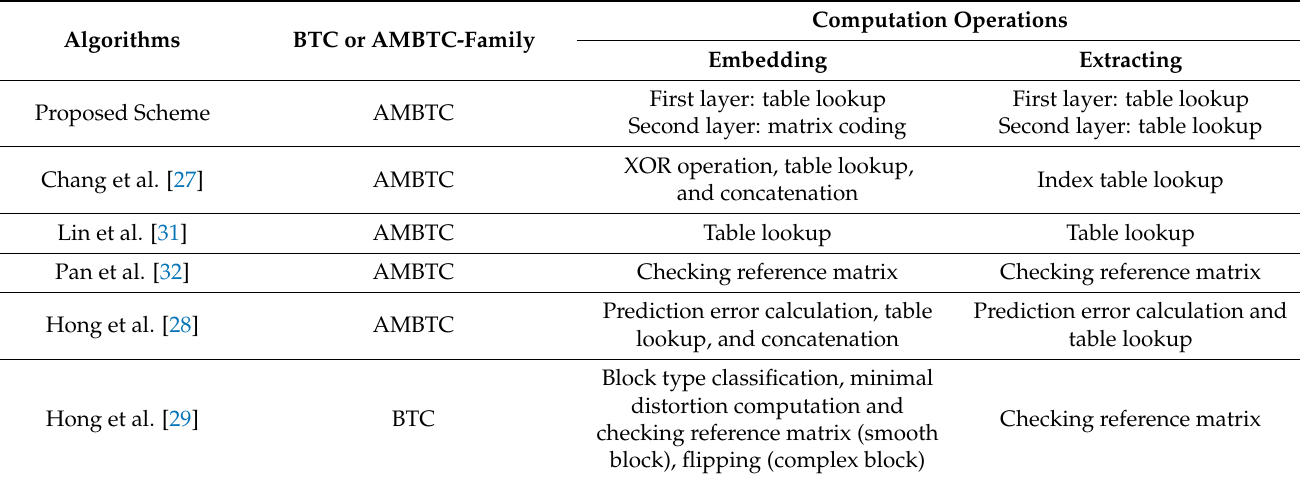
Table 7. Comparison of six methods on computation